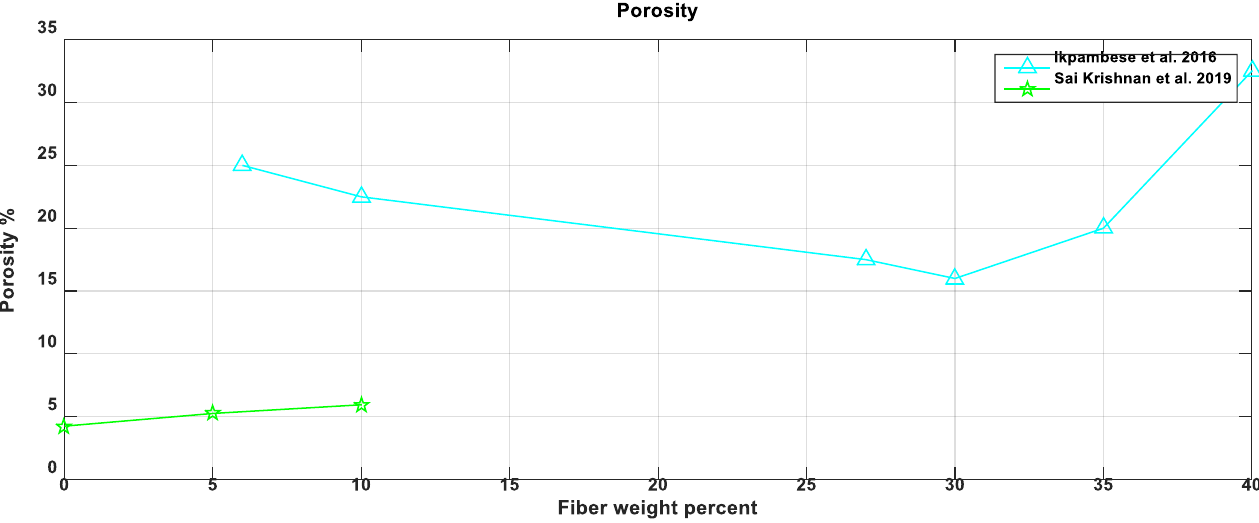
Figure 3. The density variation with variation of fiber weight percentage for different fibers [43,44,62,67].